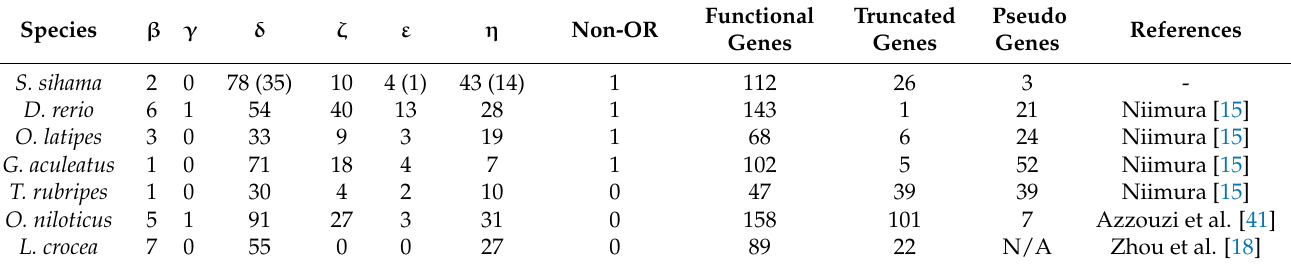
Table 1. Summary of the number of OR genes in different